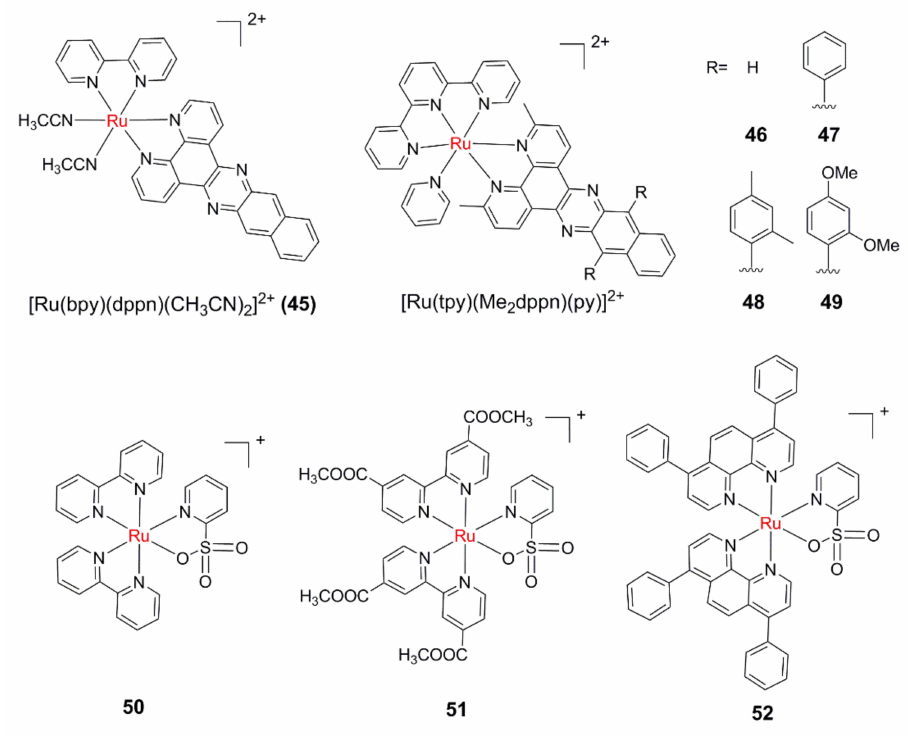
Figure 7. Ru(II) complexes with dual PACT and PDT